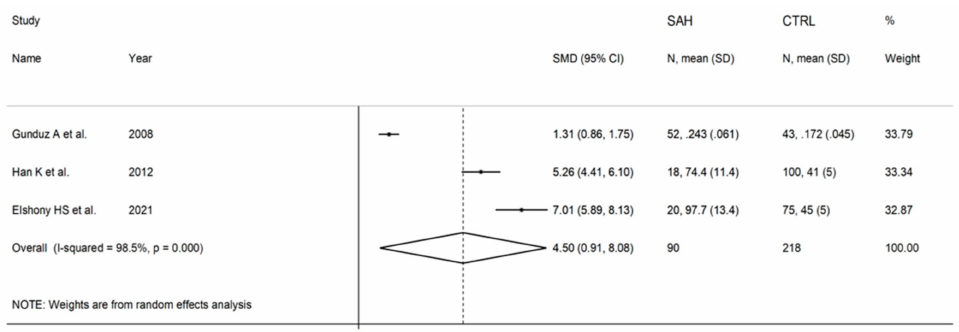
Figure 11. Forest plot of studies examining ischaemia-modified albumin in patients with subarach- noid haemorrhage and